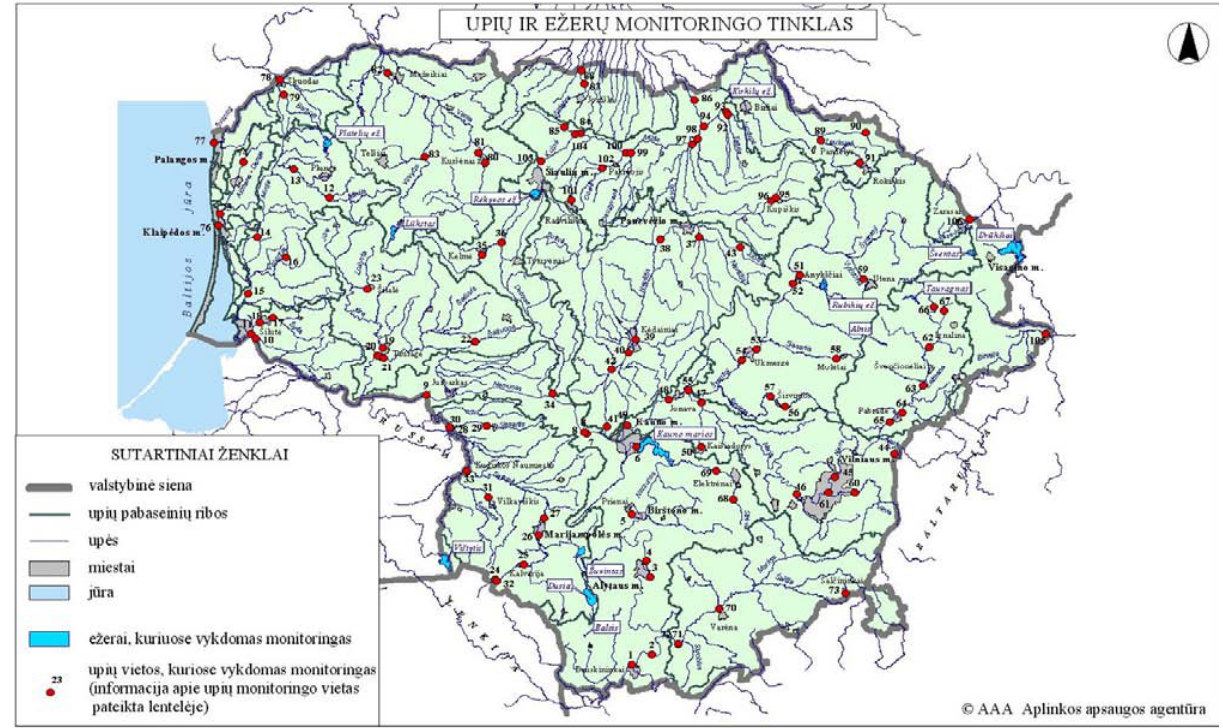
Fig. 1. Monitoring stations of lakes and rivers in Lithuania